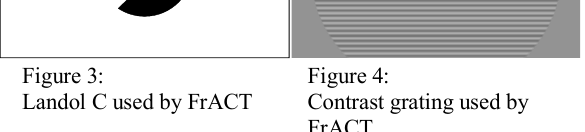
Figure 4: Contrast grating used by